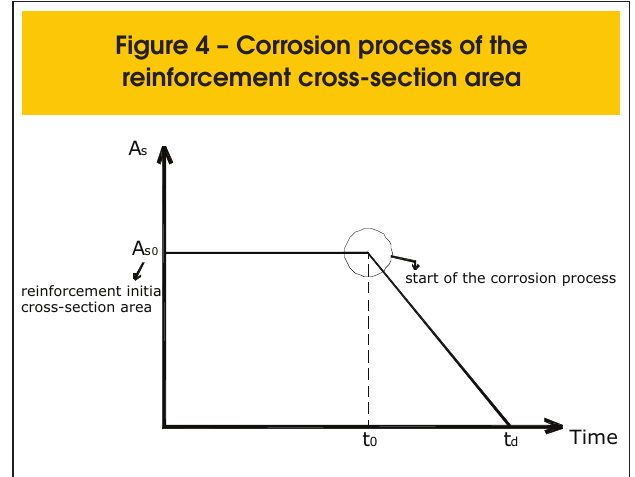
Figure 4 – Corrosion process of the reinforcement cross-section